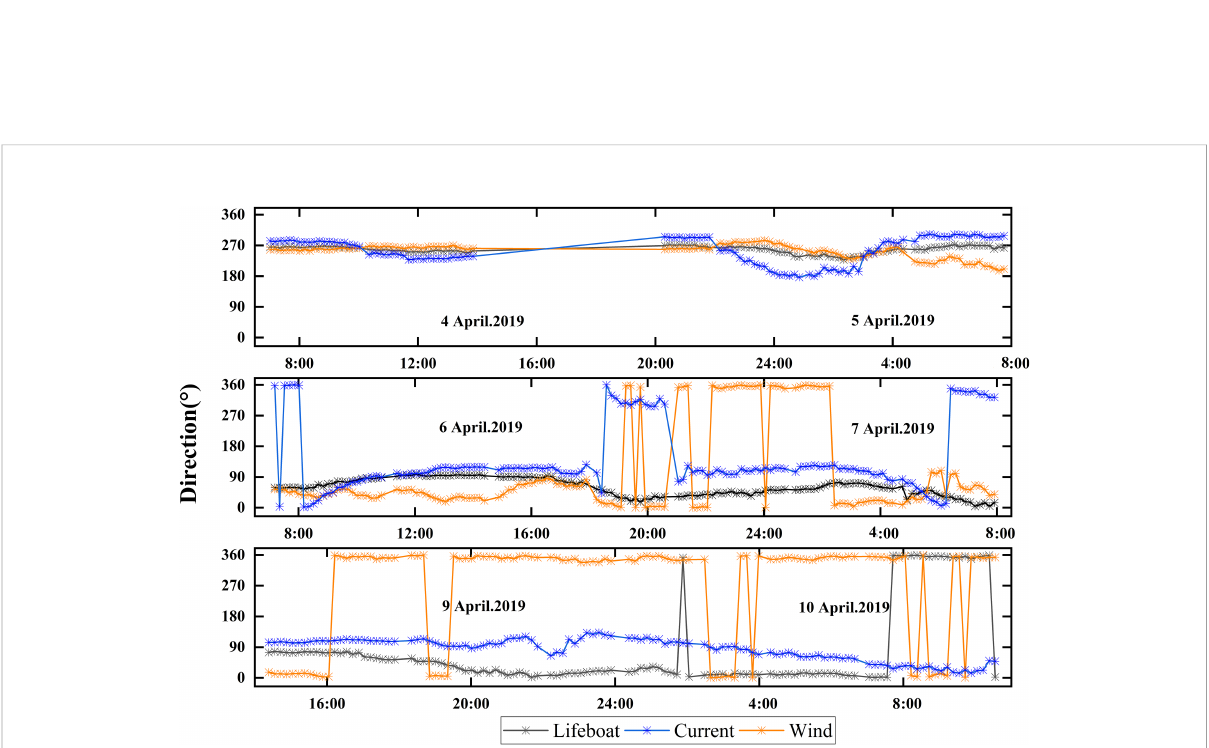
FIGURE 6 Directions of drift speed, wind speed and current speed over time for the open lifeboat, with the black lines representing the open lifeboat, the blue lines representing the current, and the orange lines representing the